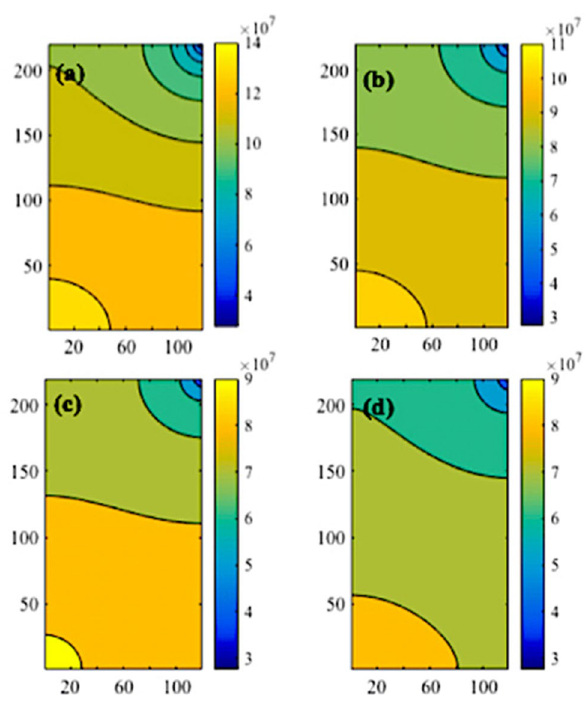
Fig. 2 Pressure distribution (in Pa) in the reservoir at: a 250 days, b 500 days, c 750 days, and d 1000 days (injection well at the lower left corner; production well at the upper right corner)